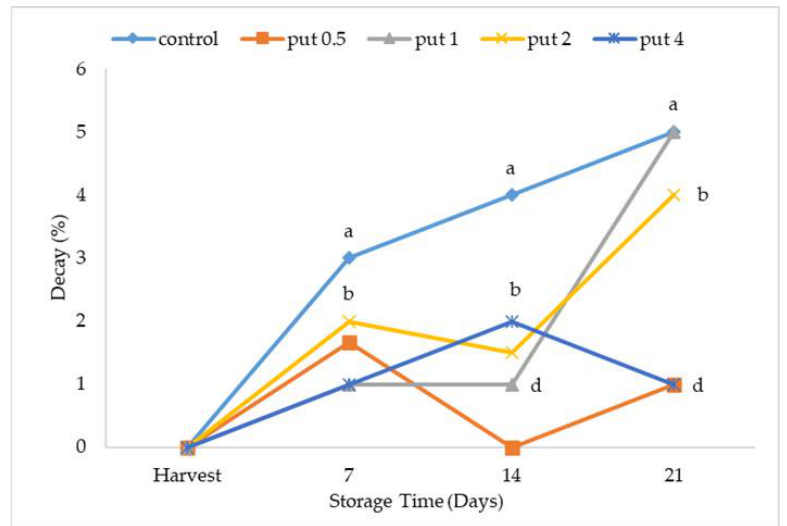
Figure 2. Effect of putrescine treatment on decay ratio of fig fruit during cold storage. Put 0.5, 1, 2 and 4 indicates putrescine doses of 0.5 mM, 1 mM, 2 mM, and 4 mM, respectively. According to the Tukey test, p < 0.05 does not differ between the same letters in the same harvest